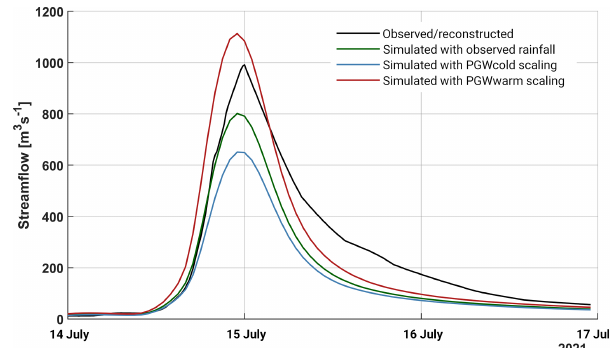
Figure 10. Streamflow at gauge Altenahr (Ahr). Black is from ob- servation and reconstruction (cf. Part 1), green is from LARSIM- Ahr simulation forced with observed rainfall (Bardossy et al., 2022), blue is from simulation with PGWcold rainfall scaling, and red is from simulation with PGWwarm rainfall scaling.